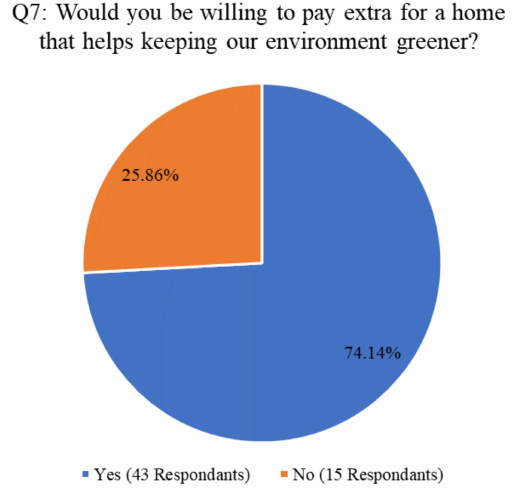
Figure 8. Participants’ willingness to pay more for NZE